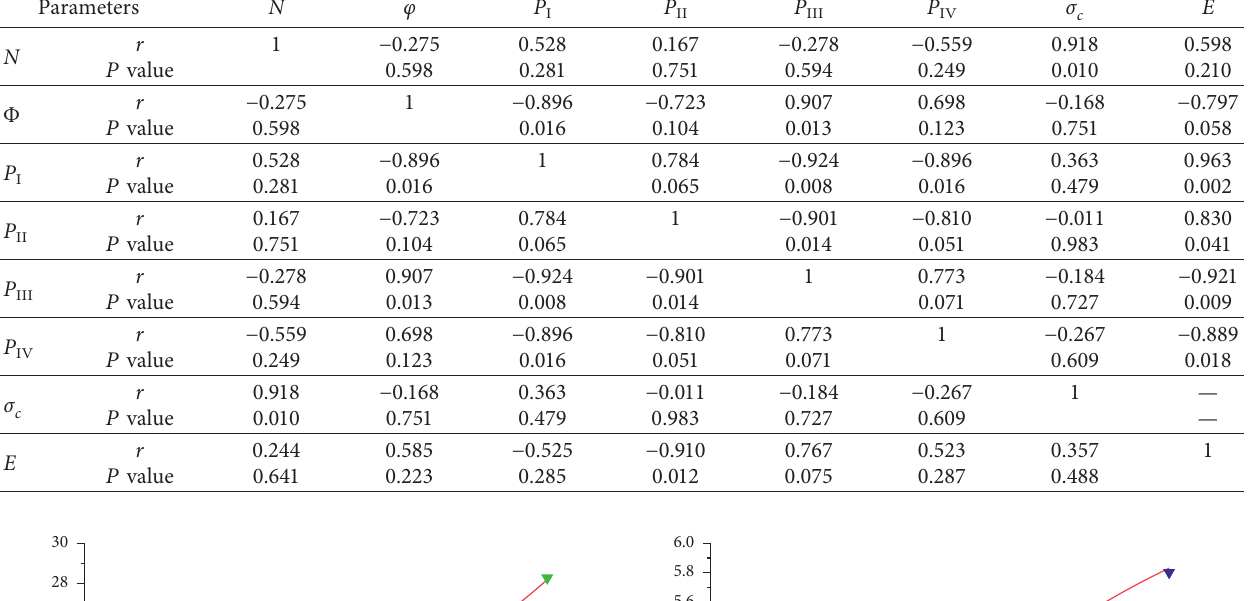
Table 1: Correlation analysis of the microstructural and mechanical parameters under uniaxial compression.